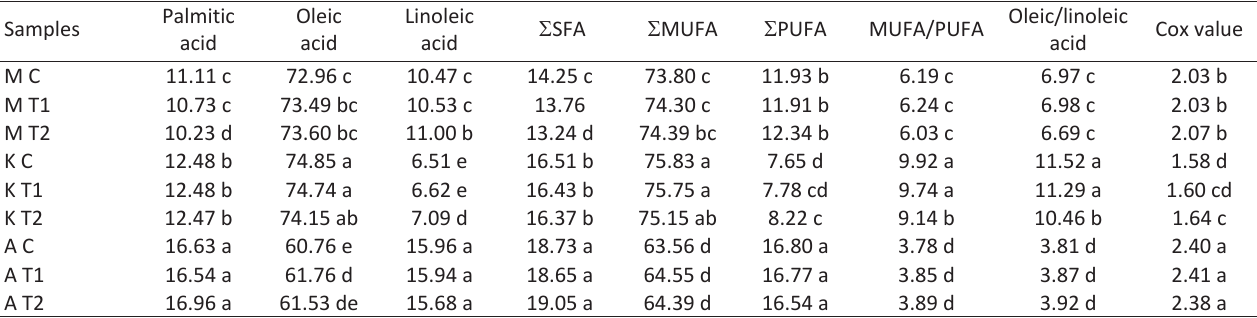
M= Mission; K= Koroneiki; A= Arbequina; C= control sample. T1= 1 week freezing sample; T2= 3 week freezing sample. SFA= saturated fatty acids; MUFA= monounsaturated fatty acids; PUFA= polyunsaturated fatty acid; Cox value: calculated oxidizability. Means within a column with the same lowercase letters are not significantly different.